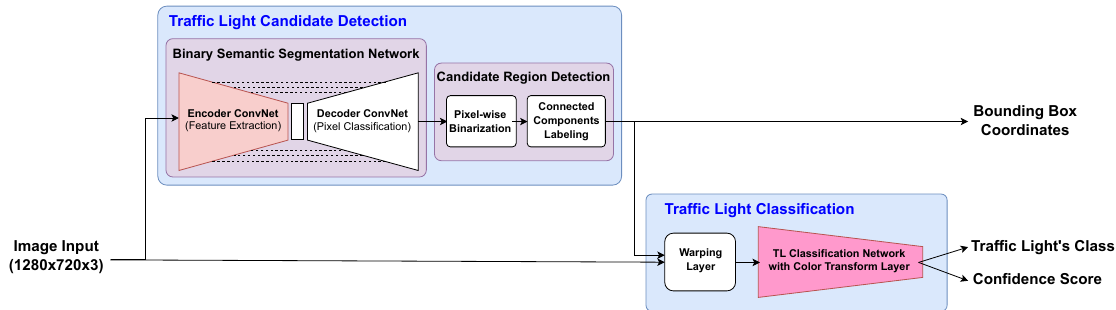
Figure 1. Proposed two-staged traffic light recognition